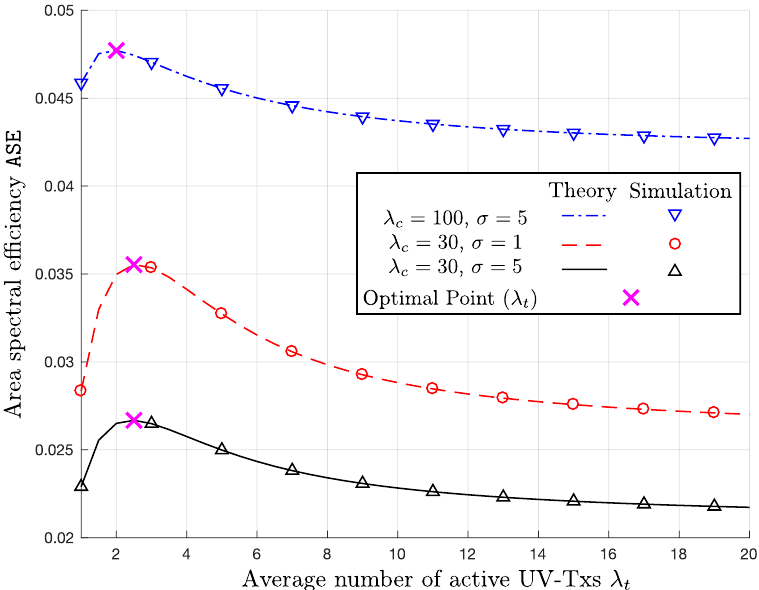
Figure 6. ASE versus λ t with ( λ c , σ ) = { ( 100,5 ) , ( 30,1 ) , ( 30,5 ) } and β = 0 dB.